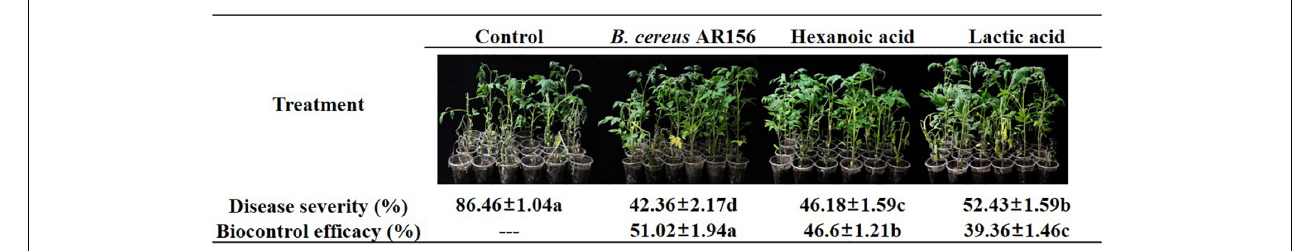
FIGURE 6 | Biocontrol efficacy of Bacillus cereus AR156 and different components from tomato root exudates induced by B. cereus AR156 (Hexanoic acid and Lactic acid) against bacterial wilt caused by Ralstonia solanacearum HN4 under greenhouse condition. The mean and standard error values of three biological replicates are reported for each treatment. Different letters within a row indicate significantly differences among treatments by the Duncan’s multiple range tests test ( P < 0.05). The experiment was carried out three times and one representative experiment is reported.